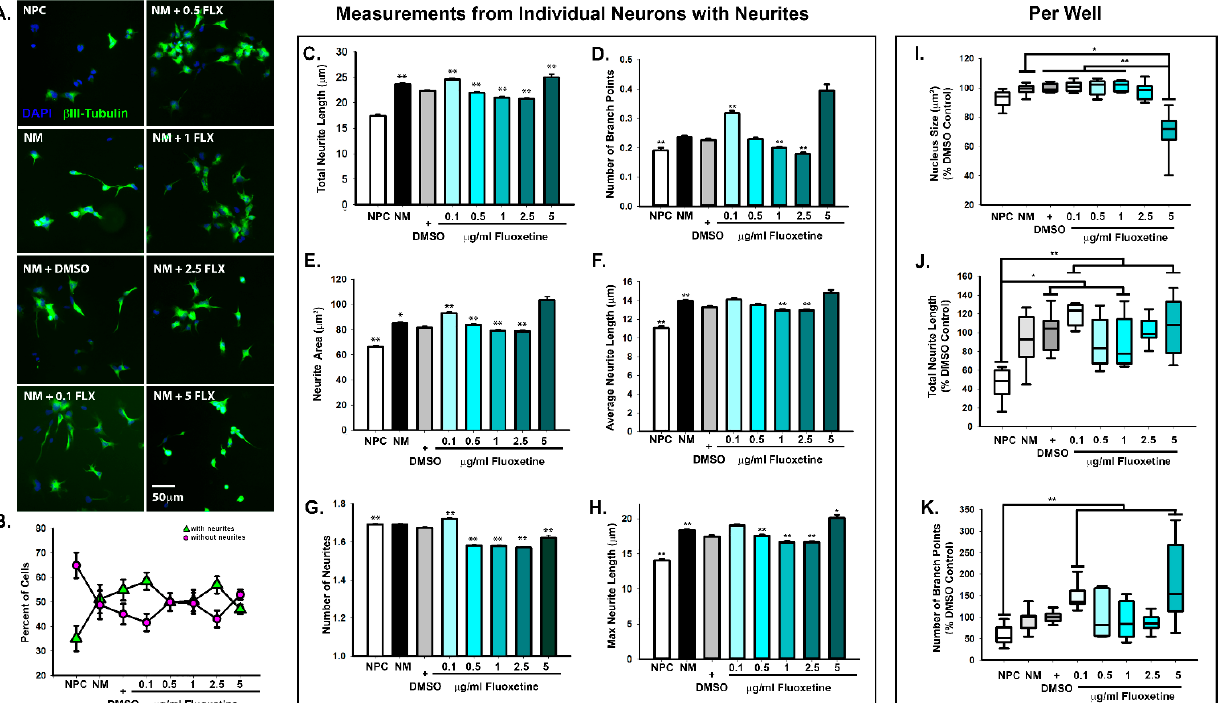
Figure 1. Effects of fluoxetine on neurite formation. ( A ) Human induced pluripotent stem cell derived neural progenitor cells were differentiated into neurons for 24 h in the presence of increasing concentrations of fluoxetine (FLX) before fixation and immunostaining with the neuronal marker, β III-Tubulin and DAPI. As a control, cells were maintained in neural progenitor cell media. Cells were imaged and analyzed on the automated high content imaging system, and the experiment was performed in triplicate. Scale bar = 50 μ m. ( B ) Analysis of the percentage of β III-tubulin-positive cells with or without neurites. Note that while some NPCs express β III-tubulin after 24 h of attachment at low-density to laminin-coated plates, the majority do not express neurites. ( C – H ) In the β III-tubulin-positive cells with neurites, we analyzed total neurite length per neuron ( C ), branch points ( D ), neuron area ( E ), average neurite length ( F ), number of neurites per neuron ( G ), and max neurite length per neuron ( H ). n of β III-tubulin-positive cells with neurites = 11,044 NPC, 15,723 NM, 18,522 DMSO, 17,224 0.1 FLX, 22,227 0.5 FLX, 23,015 1 FLX, 22,775 2.5 FLX, and 5489 5 FLX. For ( C – H ), data is presented as the mean + standard error. ( I – K ) Nucleus size and neurite parameters, including total neurite length and number of branch points, were also analyzed for the entire β III-tubulin-positive population per well. n = 9 wells total for all condi- tions, except for 0.1 μ g/mL, which was analyzed in 8 wells, due to low neuron count in one well. * p ≤ 0.05, ** p ≤ 0.005, one-way ANOVA. For ( C – H ), significant differences show for comparison with DMSO control. All comparisons reported in supplemental materials.